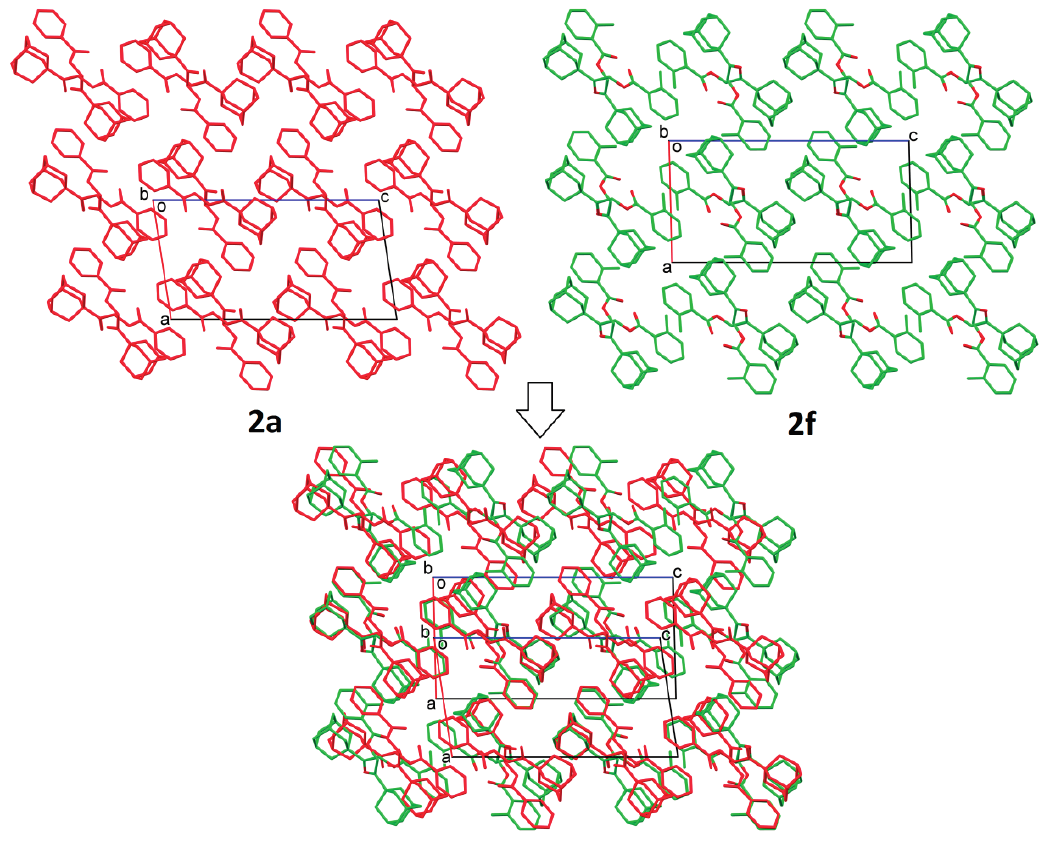
Figure 3. Crystal packing comparison of Compounds 2a and 2f .